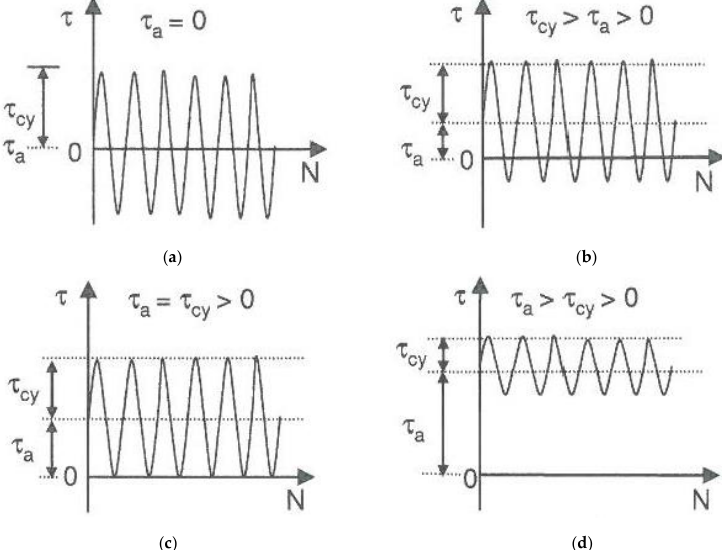
Figure 1. Modes of cyclic loading: ( a ) two-way, τ a = 0 (symmetric); ( b ) two-way, τ a > 0 (asymmetric); ( c ) one-way, τ a = τ cy ; ( d ) one-way, τ a > τ cy [1].